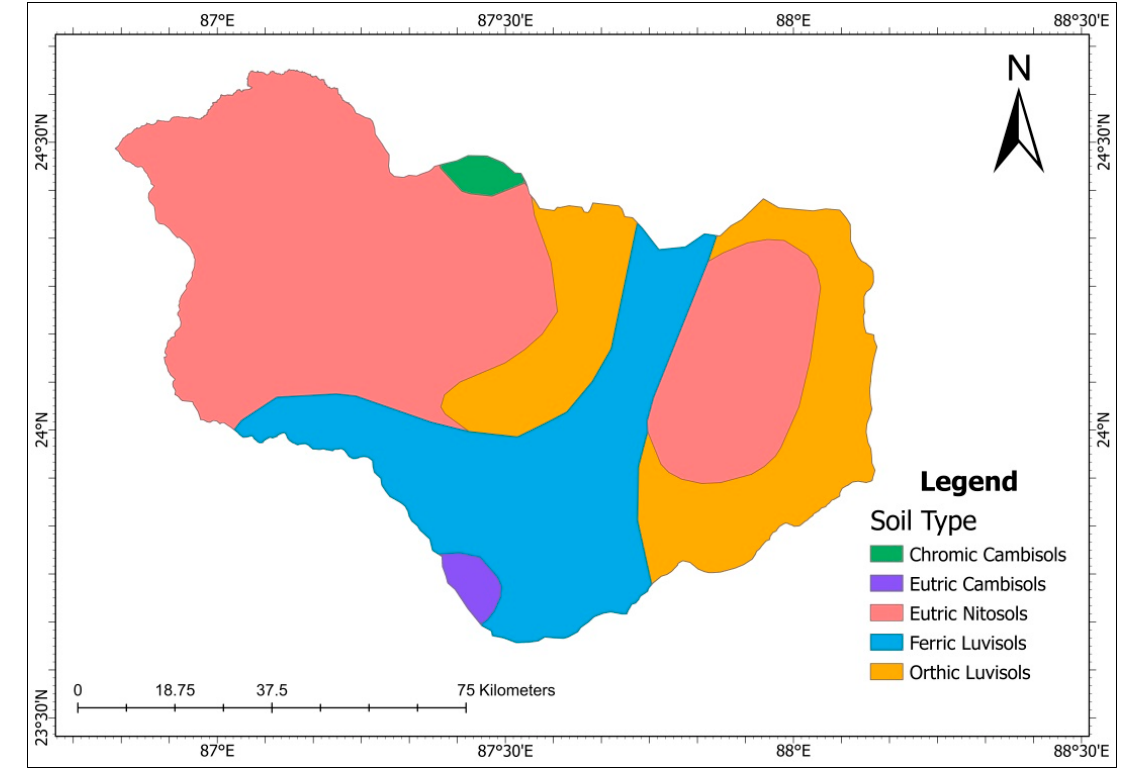
Figure 6. Soil map (derived from FAO soil).